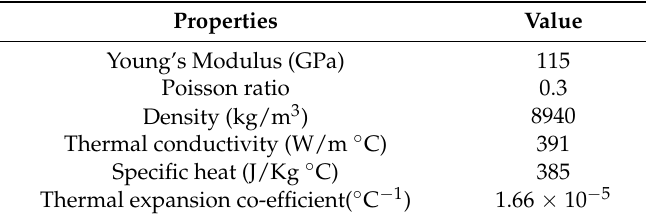
Table 2. Material properties of copper.